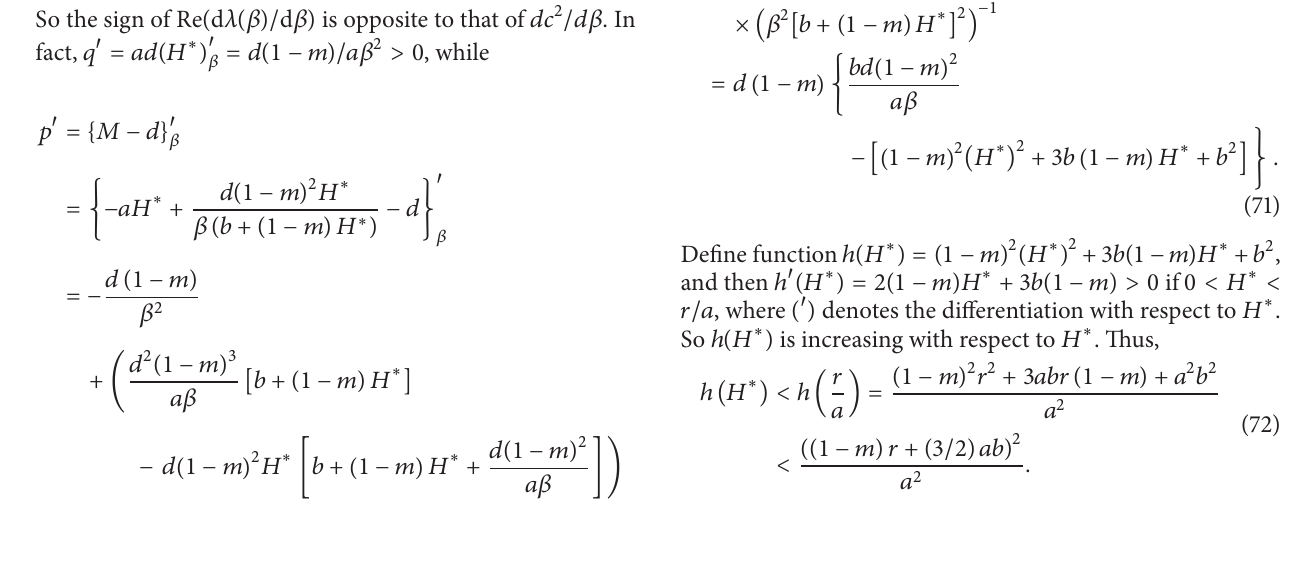
So the sign of Re ( d 𝜆(𝛽)/ d 𝛽) is opposite to that of 𝑑𝑐 2 /𝑑𝛽 .